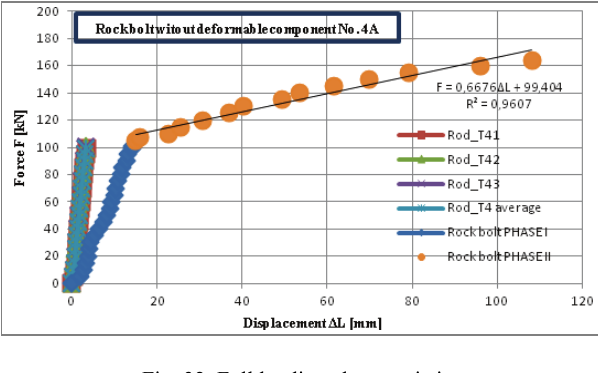
Fig. 32. Full loading characteristics for the rock bolt No. 4A